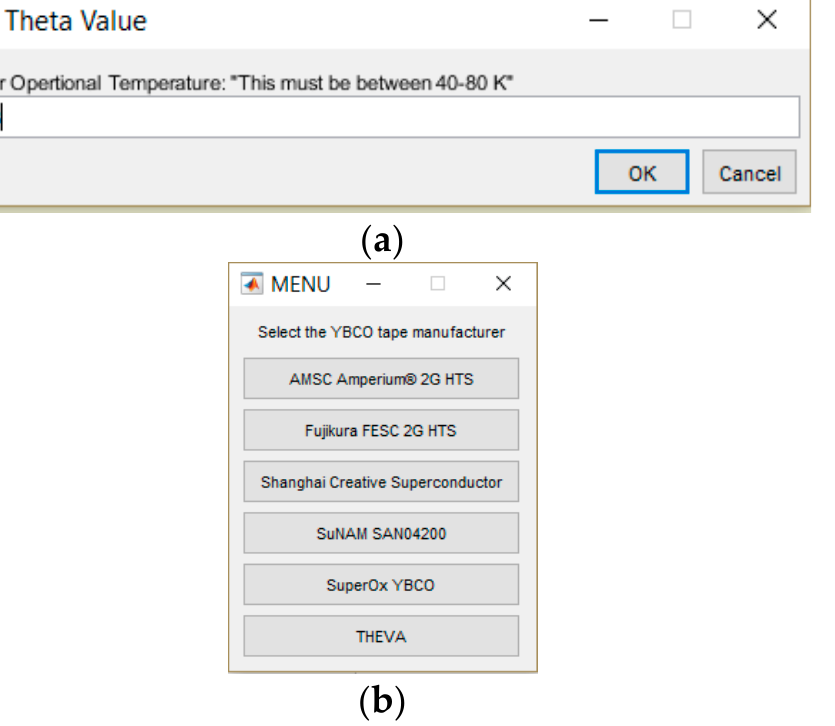
( b ) Figure 10. Current-temperature distribution of test points. ( a ) Based on quench probability. ( b ) Based on normalized operating current. 4.3. Case Studies: MATLAB Function To avoid a long computation procedure, once the model is trained, we developed a MATLAB ANN function that operates based on the trained ANN model to estimate quench probability. To test the performance of the ANN function, we tested three differ- ent tapes and fed their operating conditions into the developed MATLAB function. As shown in Figure 11a, firstly, the operating temperature is established by the program. Af- ter that, as illustrated in Figure 11b, the type of HTS tape must be selected. Three case studies are analyzed under different operating condition including current and tempera- ture for each tape. For each tape, two temperatures are considered—50 K, which repre- sents an ideal thermal condition which is much lower than the critical temperature of HTS